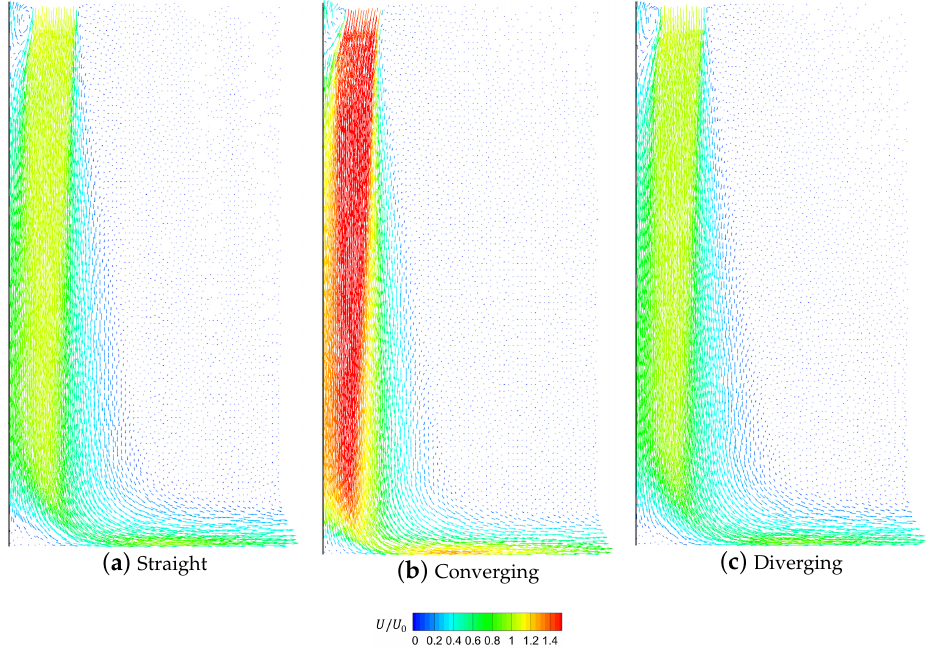
Figure 14. Velocity vector in the central r − z plane with ( a ) straight nozzle, ( b ) converging nozzle, and ( c ) diverging nozzle at H = 4, and the vector is colored by U . U 0 Figures 15 and 16 show the velocity and TKE plots at z = H , respectively. The velocity 2 of the main flow is greater in the converging case, more than 1.5 times that of the base case, while the velocity of the diverging nozzle is slightly lower than that of the base case. The velocity magnitude of the main flow in the converging case is significantly higher (over two times) with limited mixing and expansion in the restricted space between the jet exit and the target plate for small separation distances ( H = 0.5).